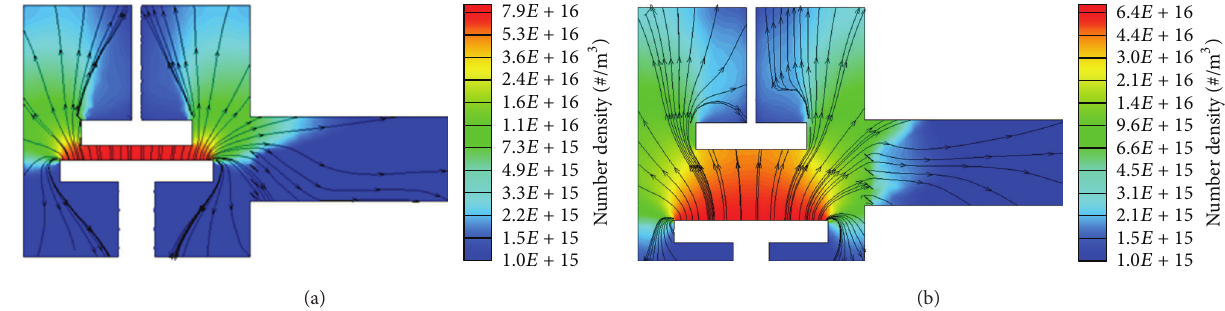
Figure 4: Number density distribution diagrams with (a) 30mm and (b) 150mm T/S distance (slice from x - y plane).